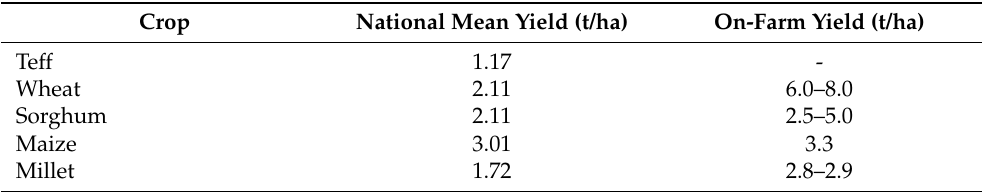
Table 1. Yields of the most common crops in Ethiopia (Source: Taffesse et al. [44]). Crop National Mean Yield (t/ha) On-Farm Yield (t/ha) Teff 1.17 - Wheat 2.11 6.0–8.0 Sorghum 2.11 2.5–5.0 Maize 3.01 3.3 Millet 1.72